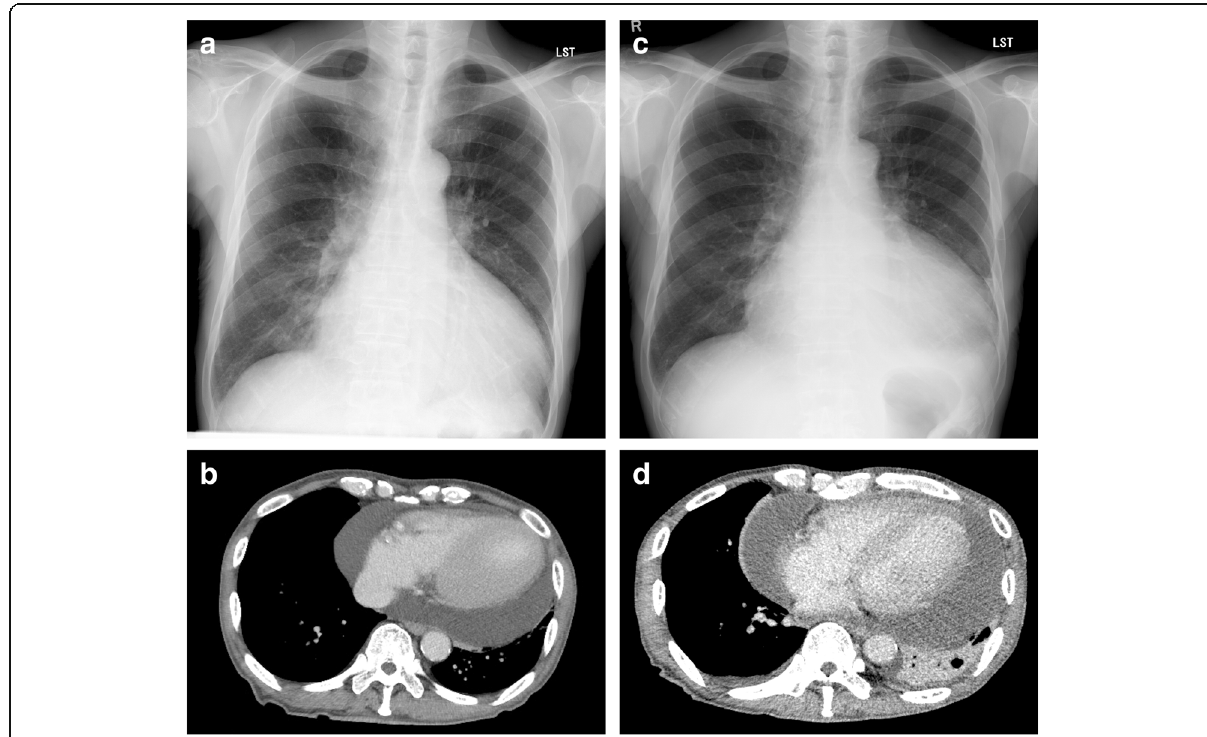
Fig. 1 Severe cardiomegaly revealed on chest radiography at the initial outpatient appointment ( a ). Chest computed tomography showed a large pericardial effusion with an estimated volume of 700 mL ( b ). Cardiomegaly worsened 4 weeks after the initial appointment ( c ). Chest computed tomography showed a huge pericardial effusion with an estimated volume of 1300 mL ( d